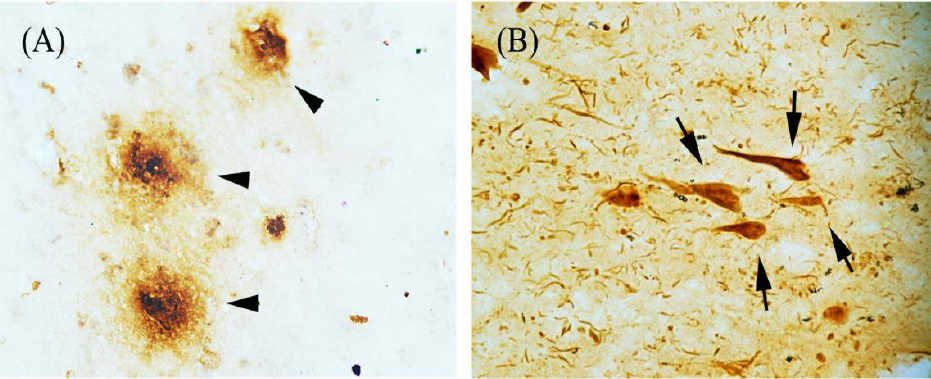
Figure 1. Characteristic hallmarks of Alzheimer’s disease (AD) brains. Bright-field immunohistochemistry microscopic images from hippocampus of an AD patient: ( A ) Amyloid beta plaques (arrowhead) and ( B ) Neurofibrillary tangles (arrows), formed by abnormal accumulations of A β and tau-p protein, as recognized by specific antibodies, respectively.